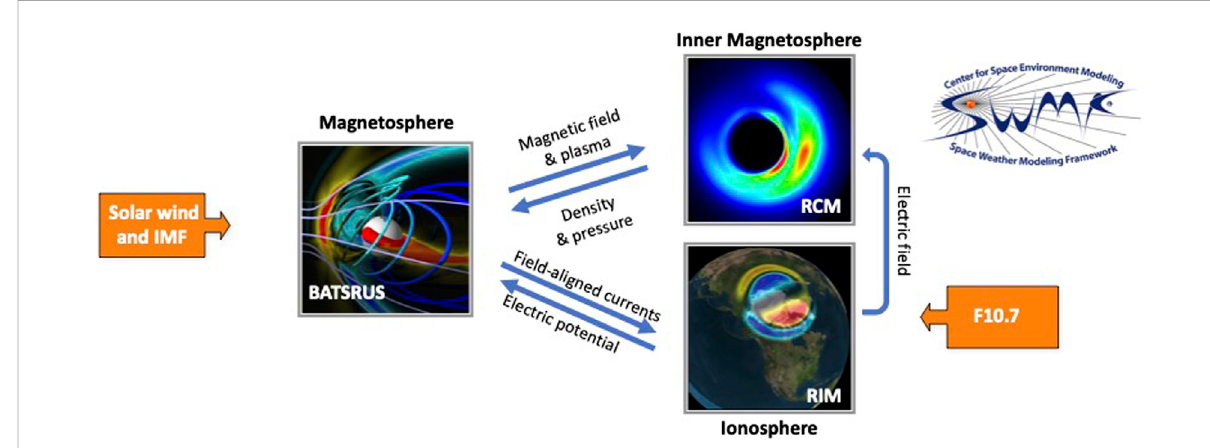
FIGURE 1 The SWMF Geospace model setup. The arrays indicate the one-way or two-way couplings between the modules (see text). The orange boxes indicate model input parameters.